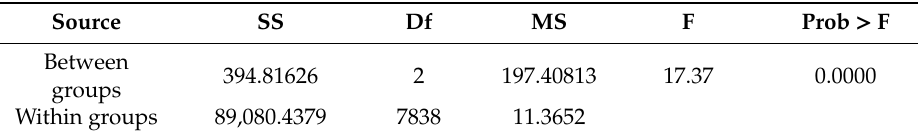
Table 4. Analysis of Variance.